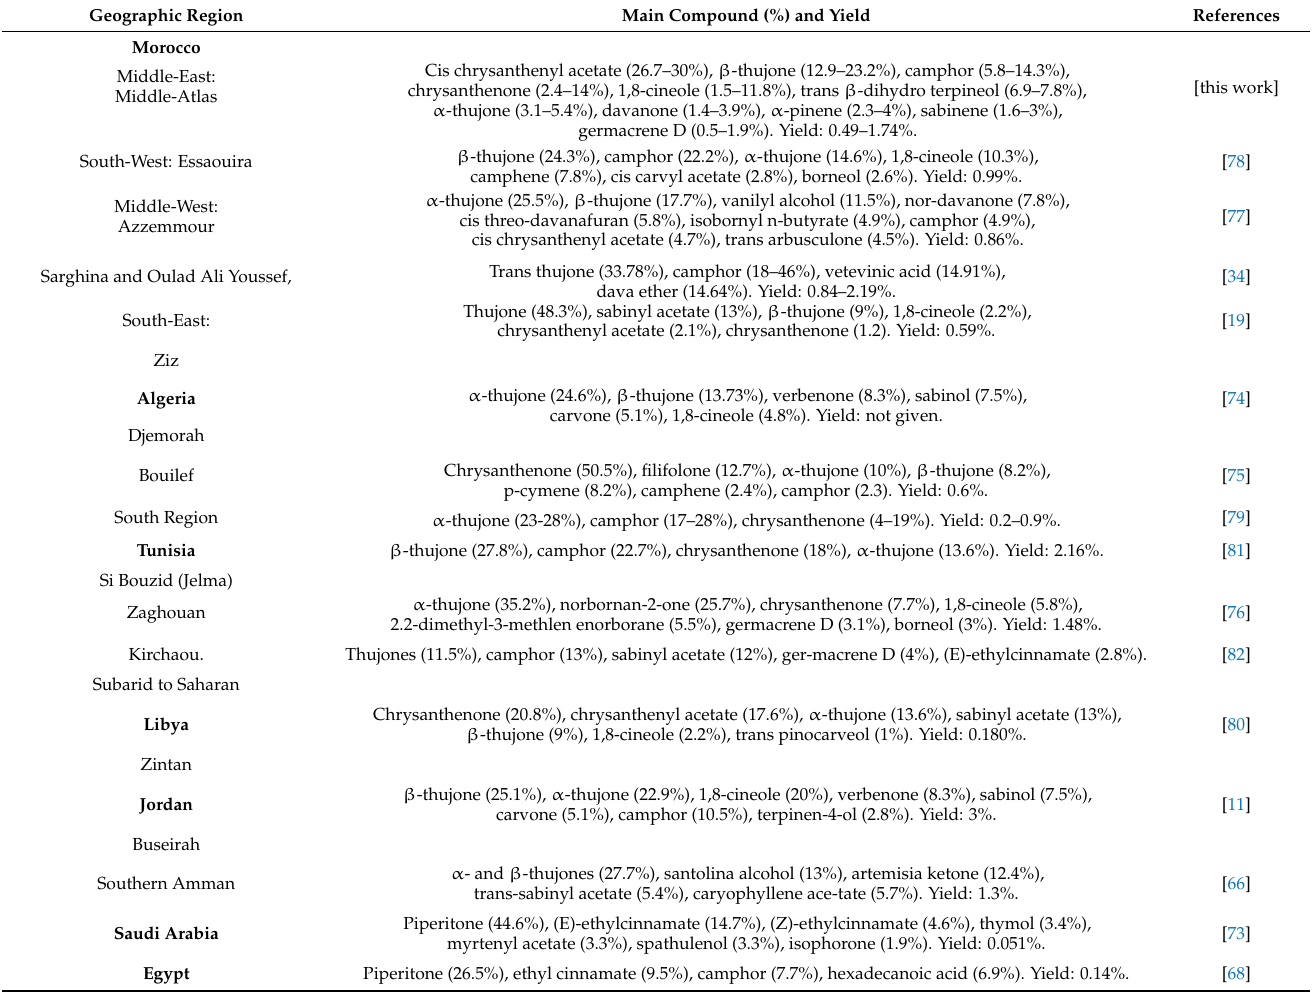
Table 3. Comparison of updated literature data concerning the main chemical composition and yield of Artemisia herba-alba essential